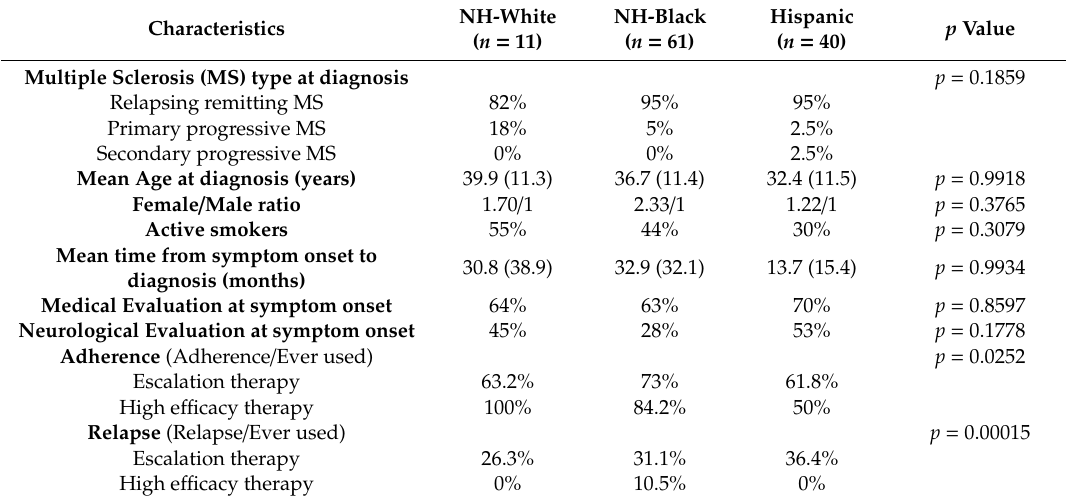
Table 1. Diagnosis Characteristics of patients with MS stratified by race / ethnicity.